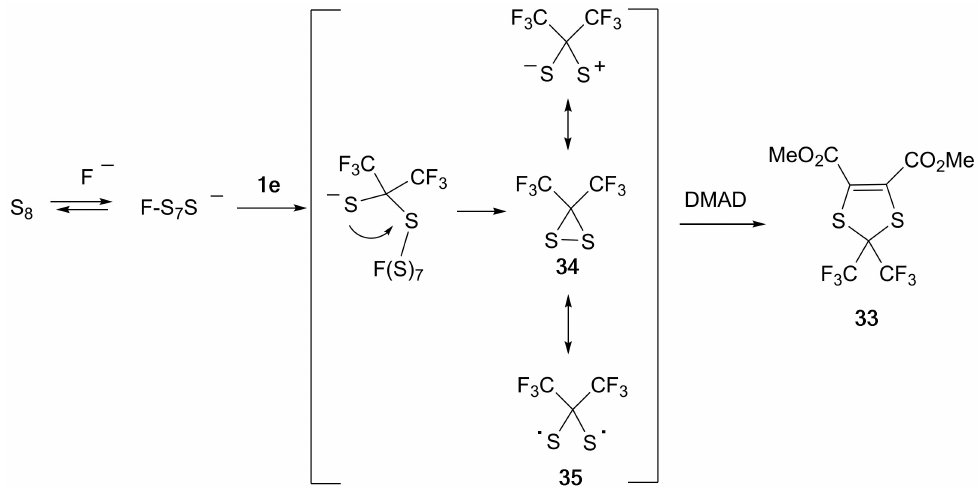
Scheme 15. Proposed mechanism of the fluoride anion-catalyzed sulfurization of perfluoropropene; participation of 3,3-bis(trifluoromethyl)dithiirane ( 34 ) in the formation of 1,3-dithiole 33 . 4.4. 1,2-Dithiolanes The 3,3-bis(trifluoromethyl)-5-alkoxy-1,2-dithiolanes 36 were prepared by the CsF- initiated reaction of 4-alkoxy-2,2-bis(trifluoromethyl)thiethanes 9a (see Section 3.1)